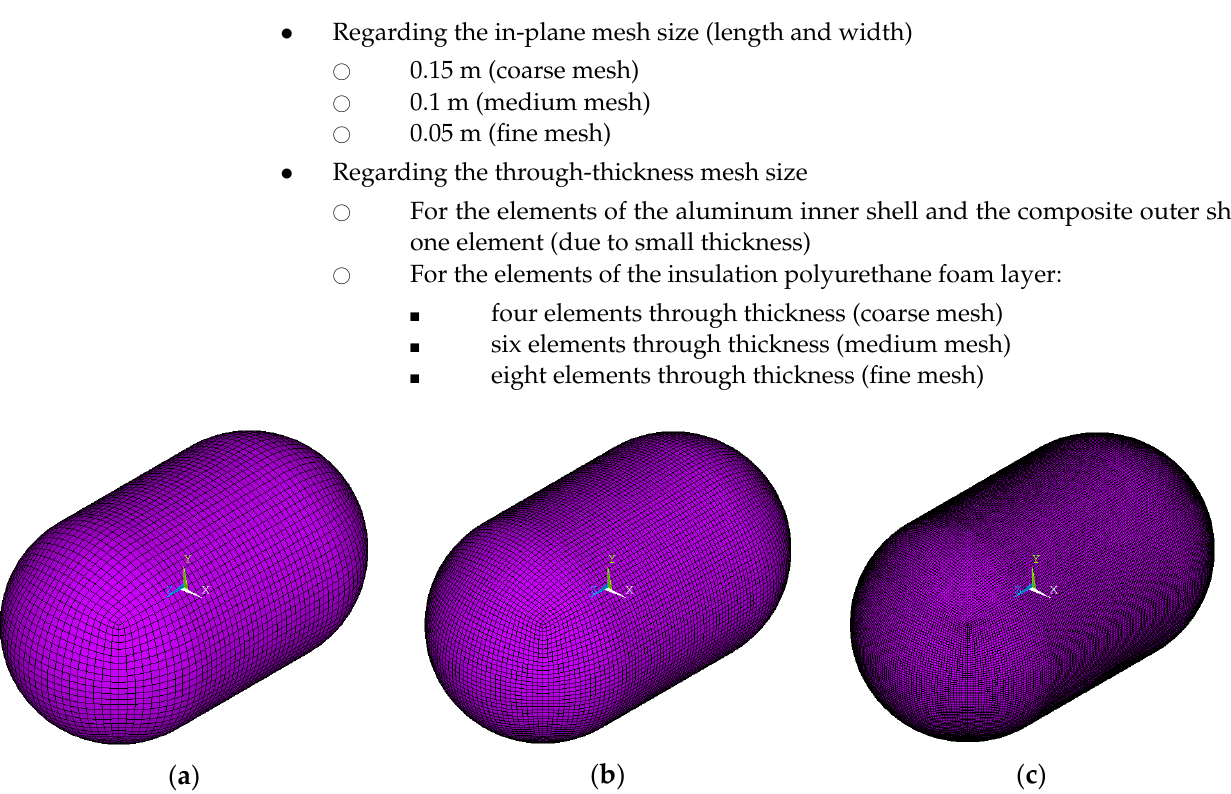
Figure 4. General view of the tank with the different mesh sizes examined: ( a ) coarse, ( b ) medium, ( c ) fine.